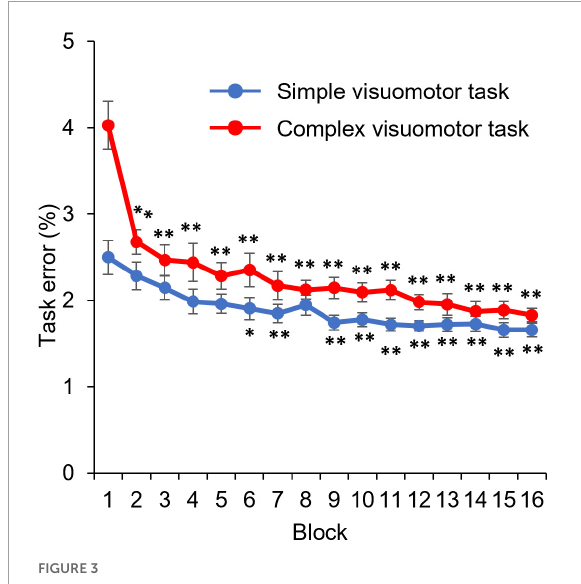
FIGURE4 Motor learning efficiency under each condition. The blue and red boxes indicate the average task error of the simple and complex visuomotor tasks, respectively. The motor learning efficiency is higher in the complex visuomotor task than in the simple visuomotor task. The error bars indicate the standard error (SE). ** p <